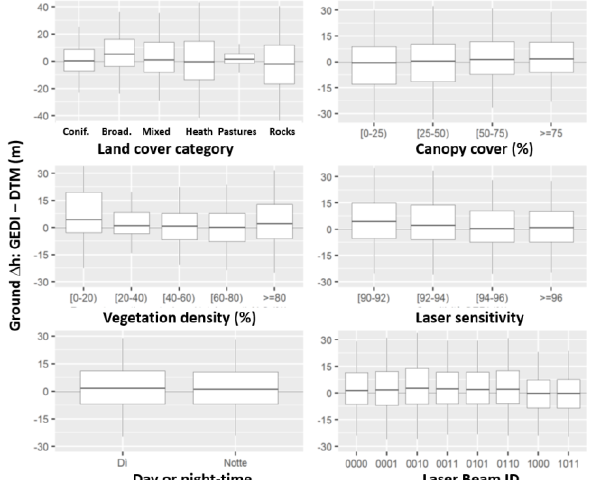
Figure 10. Error distributions of terrain height grouped by different variables.